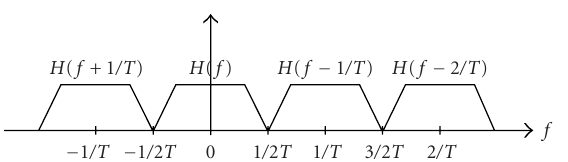
Figure 1: When H ( f ) has no excess bandwidth, H ∗ ( f + m/T ) H ( f ) = 0, for all m (cid:2)=